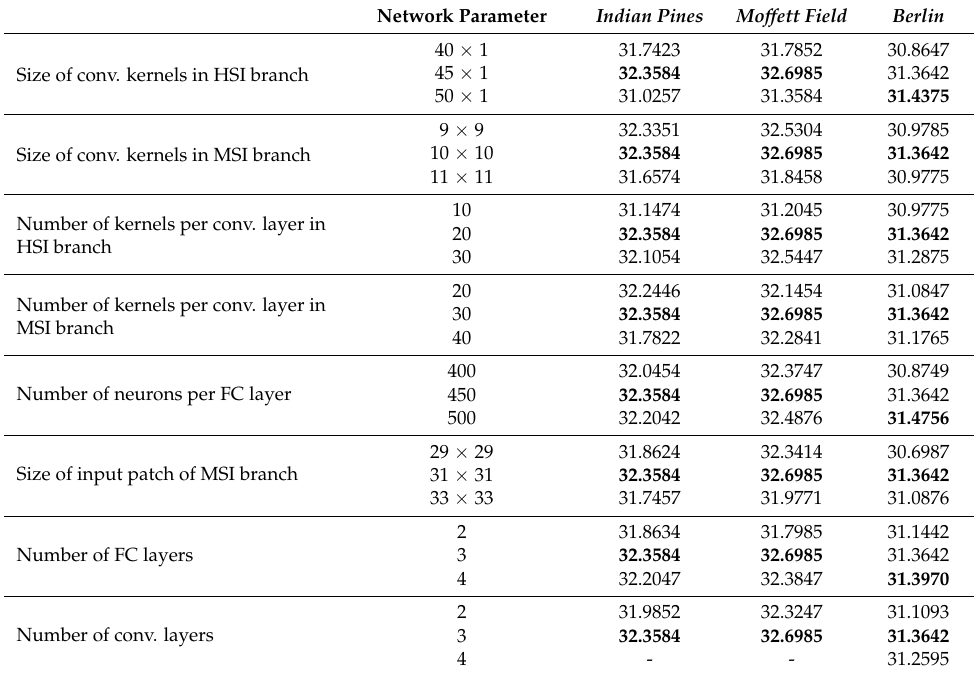
Table 8. PSNR (dB) indices of the sensitivity analysis over the network